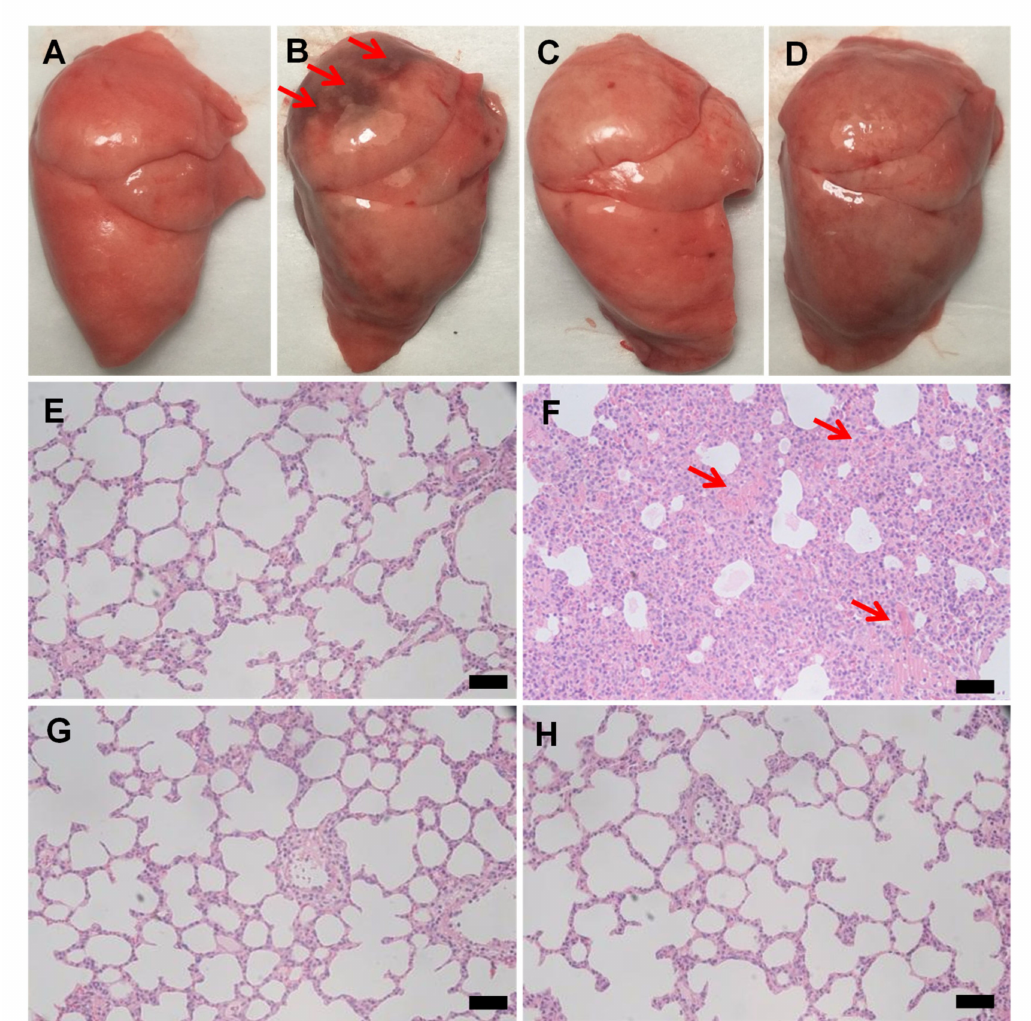
Figure 2. The appearance of the lung tissues from the healthy rats ( A ), the lipopolysaccharide (LPS)-induced model group ( B ), the dexamethasone (DXM) group ( C ), and the JNDs group ( D ). Hematoxylin and eosin (H&E) images of the lung tissues from the healthy rats ( E ), the LPS-induced model group ( F ), the DXM group ( G ), and the JNDs group ( H ). The scale bars indicate 100 µ m. The red arrows indicate lung injuries and significant hemorrhage